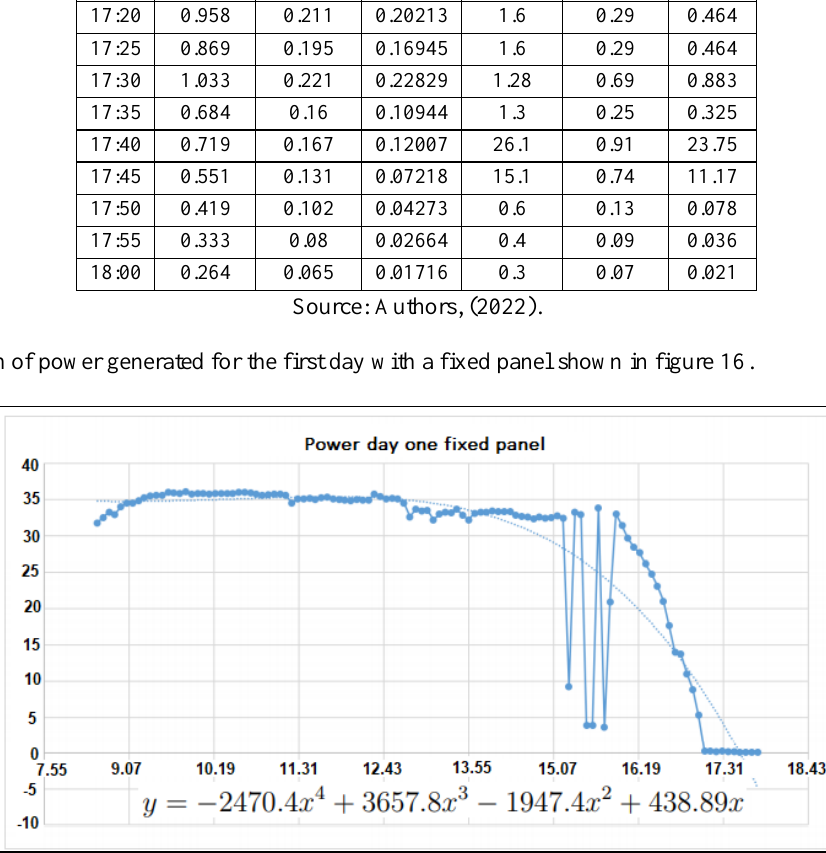
Figure 16: Graph of power generated first day with fixed panel.